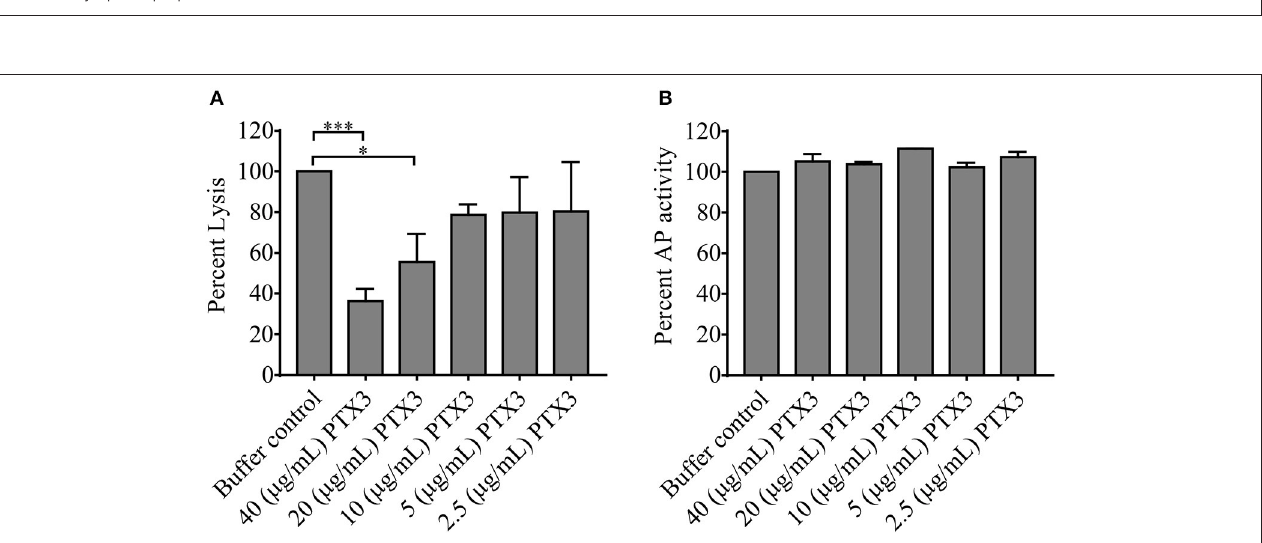
FIGURE 6 | Effect of PTX3 on AP activity in vitro. The effect of recombinant human PTX3 on AP hemolytic activity (A) and AP-mediated C9 deposition (B) is shown in percent compared to buffer control added to pooled serum of healthy individuals. Data represent mean of 3 times repeated experiments with technical duplicates, error bars indicate the standard error of mean. Statistical analysis was performed with the Kruskal-Wallis test corrected for multiple comparisons using the Dunn’s post hoc test. Statistical significance is indicated by asterisks (* p < 0.05; *** p < 0.001). AP, alternative pathway; PTX3, pentraxin-3.